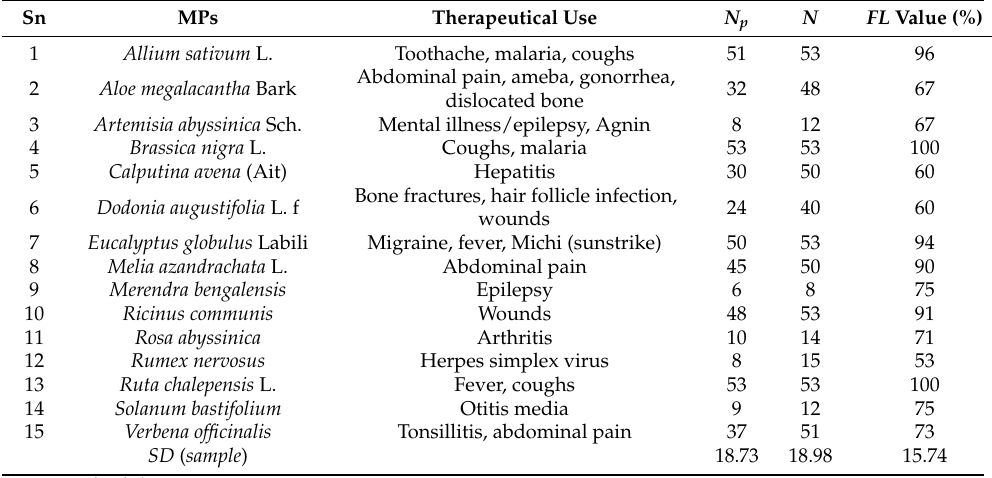
Table 4. Fidelity level (FL) values of some local commonly used medicinal plants (MPs).